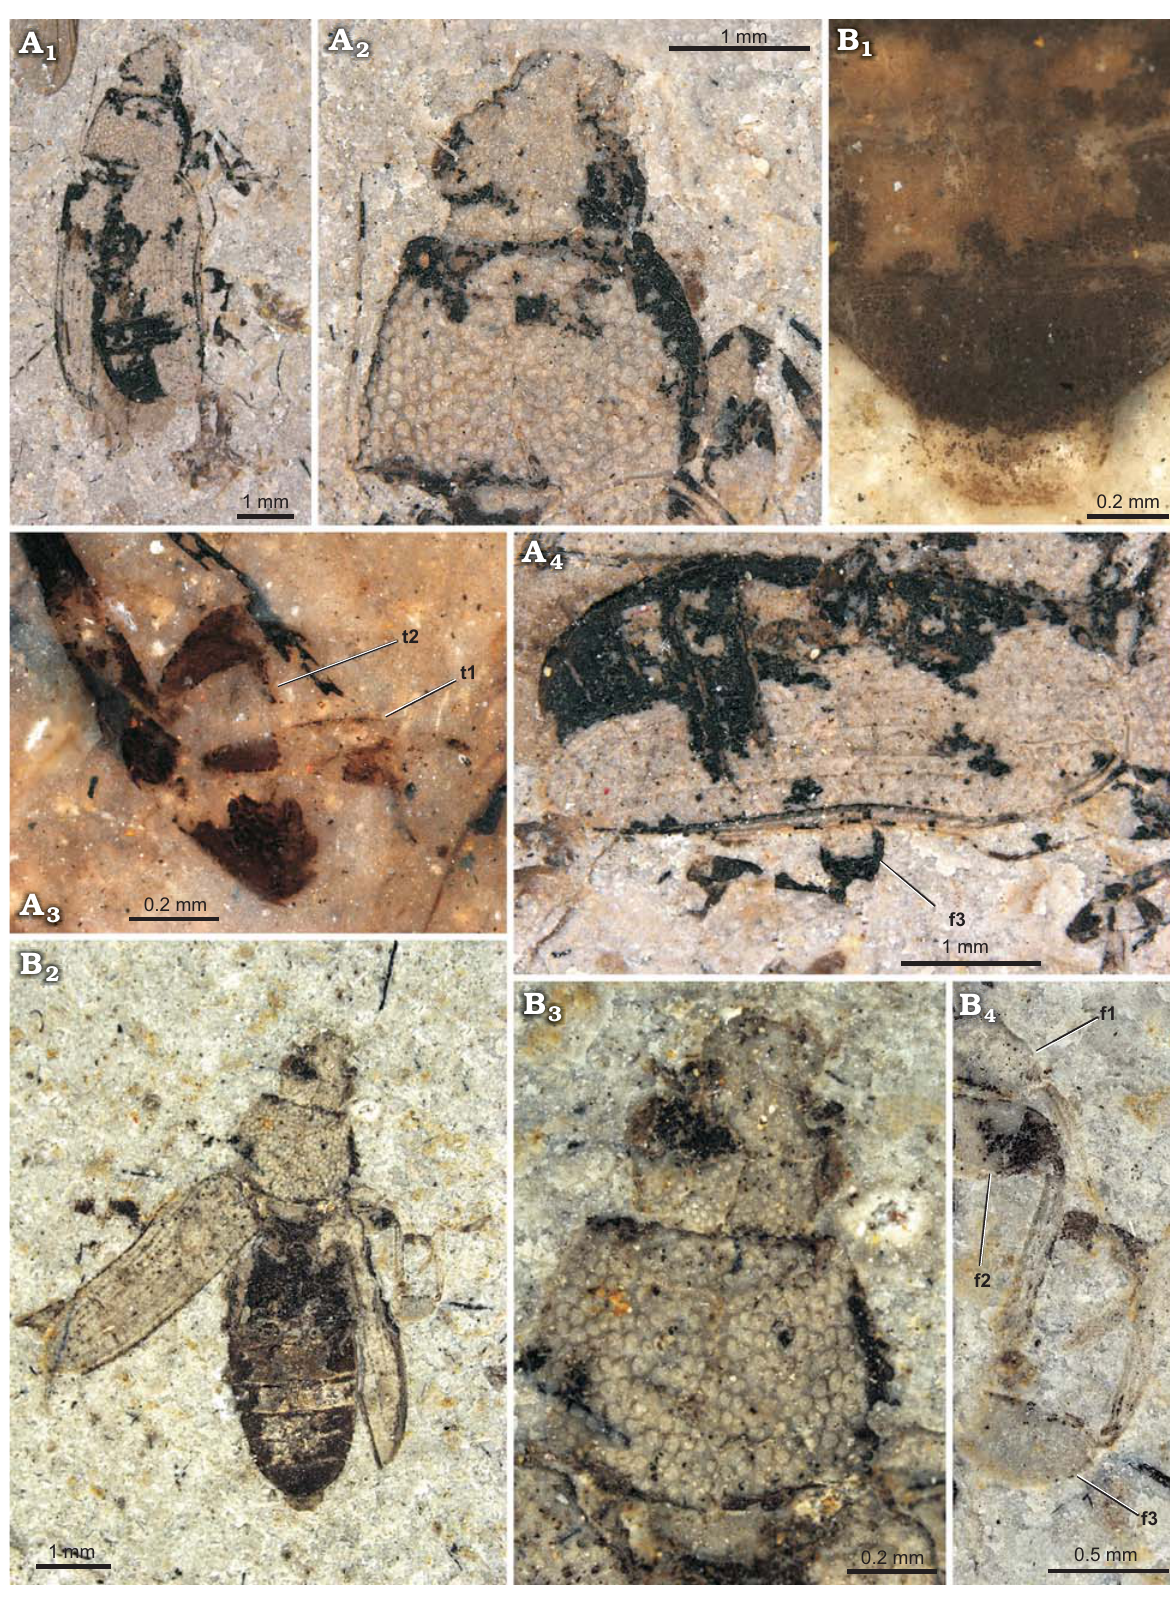
Fig. 1. Melyrid beetle Sinomelyris praedecessor gen. et sp. nov. from the Middle Jurassic Haifanggou Formation of Daohugou Village, Inner Mongolia, China. A . Paratype, NIGP168477; dorsal habitus (A 1 ), pronotum and head dorsally (A 2 ), detail of front and middle legs (A 3 ), right elytron and hind leg dorsally (A 4 ). B . Holotype, NIGP168476; abdominal apex dorsally (B 1 ), dorsal habitus (B 2 ), pronotum and head dorsally (B 3 ), detail of front, middle and hind legs (B 4 ). Abbreviations: f1–3, femora of 1st to 3rd pair of legs; t1–2, tarsi of 1st to 2nd pair of